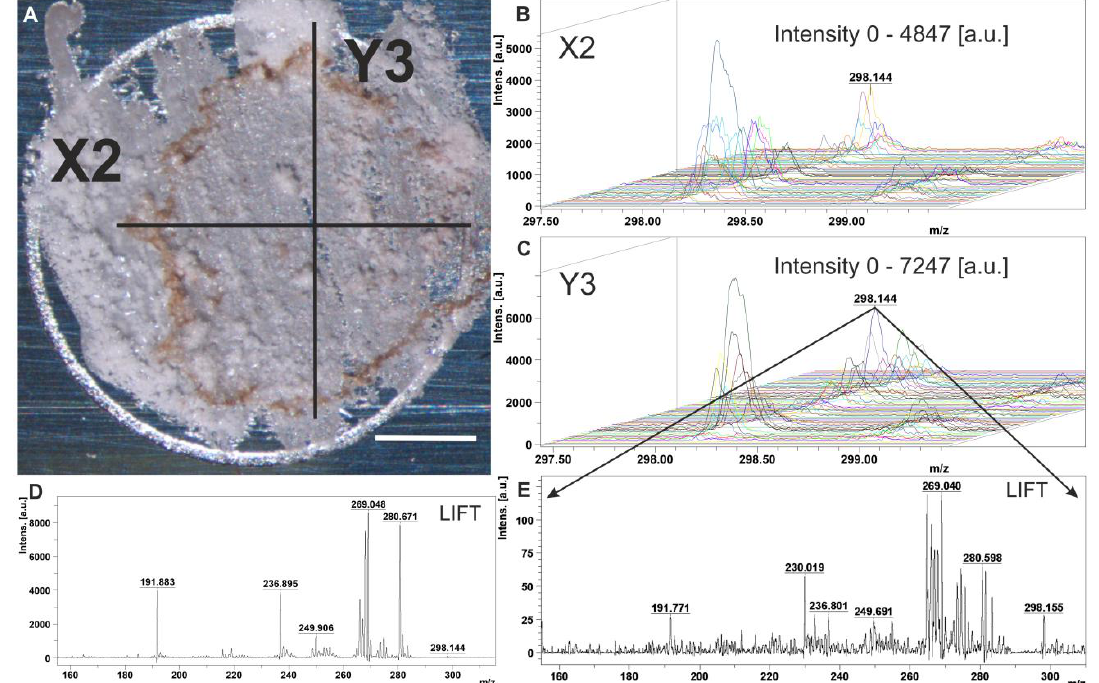
Figure 5. Direct matrix-assisted laser desorption/ionization mass spectrometric (MALDI-MS) analysis of a transverse section of the root nodule. ( A ) Image of the nodule with root sliced with raster (axis) direction. Bar, 10 mm. ( B ) MALDI-MS distribution of molecular mass m / z 298.142 across the nodule with root by raster X2. ( C ) MALDI-MS distribution of molecular mass m / z 298.142 across the root nodule by raster Y3. ( D ) MS/MS profile of precursor ions with m / z 289.144 from the root nodule. ( E ) MS/MS profile of precursor ions with m⁄z 289.144 from the standard solution. (a.u.), arbitrary units.